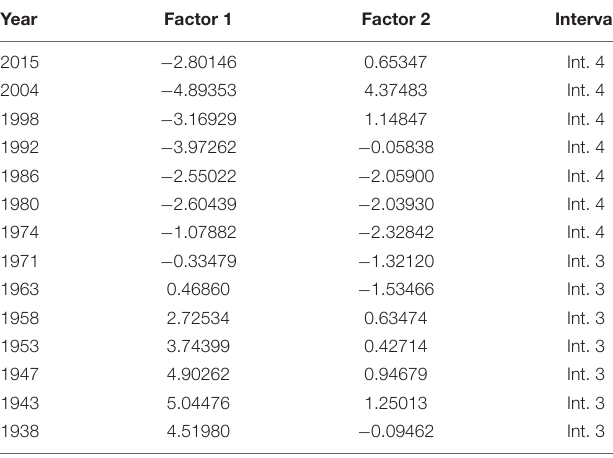
TABLE 4 | Factor 1 and factor 2 of the PCA included in Figure 7A as a function of years from intervals 1 to 4 (based on